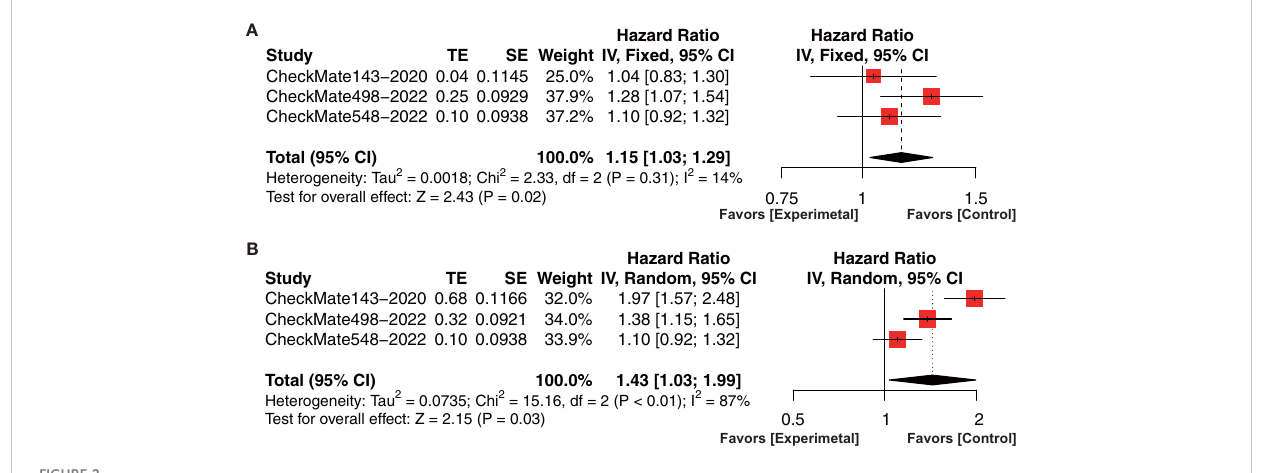
FIGURE 2 Forest plot showing the effect of anti-PD-1/PD-L1 treatment on (A) OS and (B) PFS in glioma patients in clinical trials. OS, overall survival; PFS, progression-free